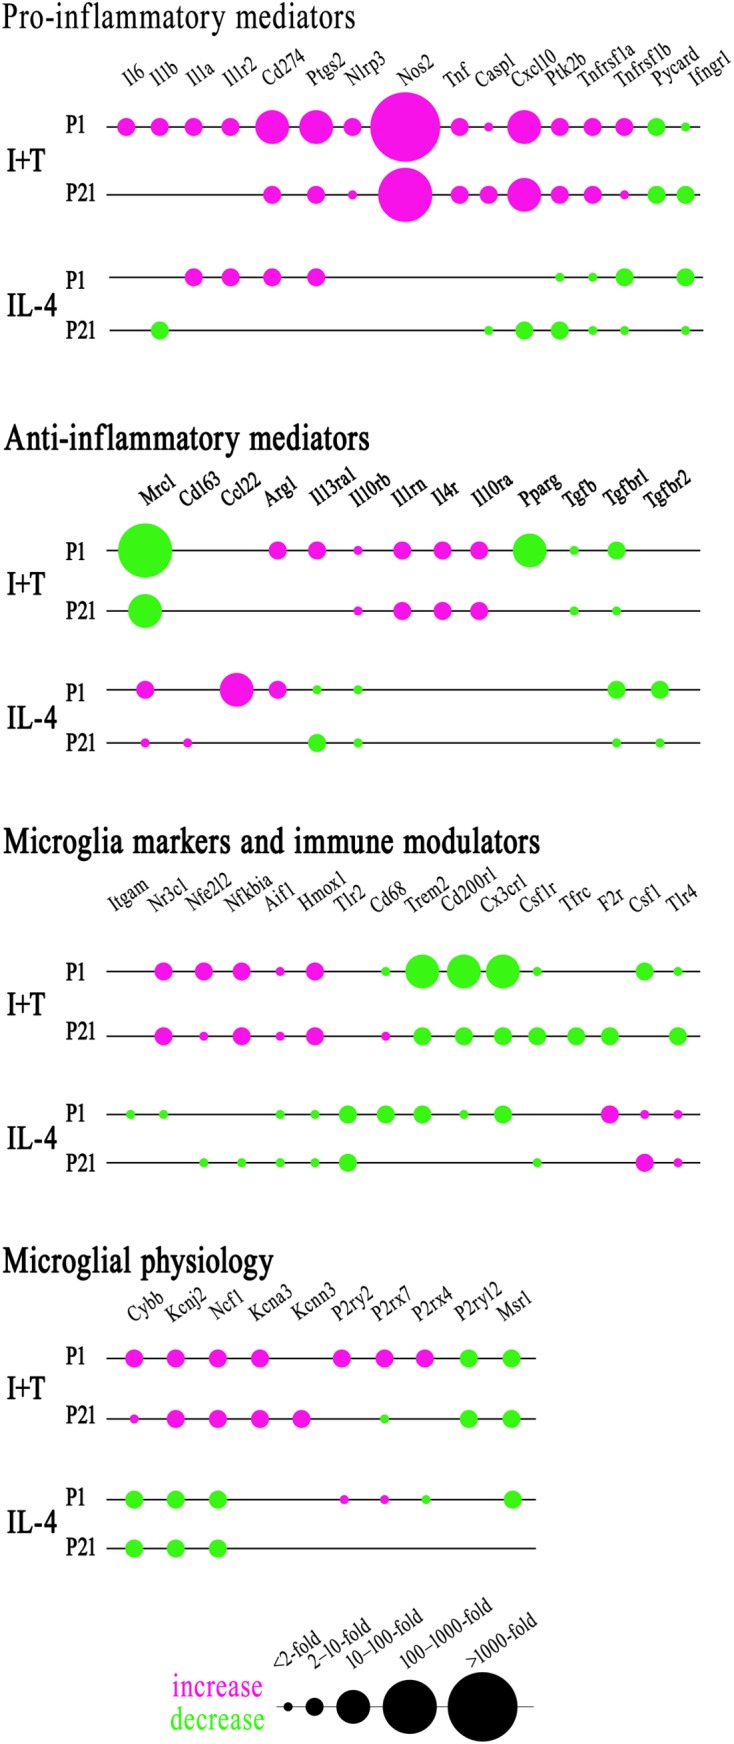
Summary of the magnitude and direction of gene expression changes in neonatal (P1) and prepubertal (P21) microglia. Sexes were combined because no sex differences were identified at either age. To create the bubble chart, fold changes were sorted into bins according to the ranges stated on the figure. Only genes showing changes in expression were included. See Figures 3–6 for full data and significance levels. The chart shows fold changes evoked by I+T or IL-4 relative to control values (magenta = increases; green = decreases).